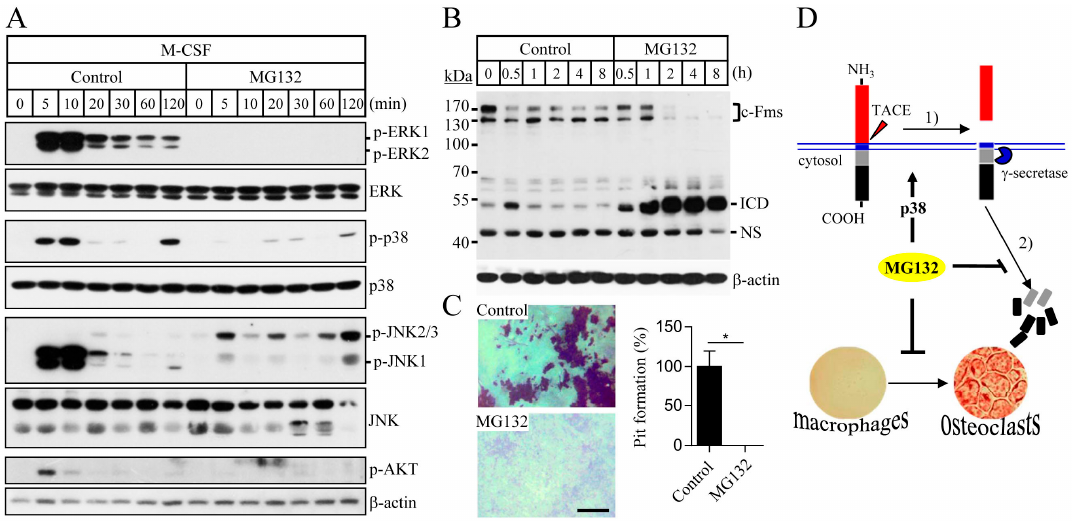
Figure 4. A proteasome inhibitor blocks M-CSF-induced intrinsic signaling and osteoclastic bone resorption. ( A ) Osteoclast progenitors were incubated with MG132 (10 μ M) for 4 h in the absence of M-CSF and then were treated with M-CSF (30 ng/mL); ( B ) osteoclast progenitors were cultured with M-CSF and RANKL for 4 days. The resulting mature osteoclasts were starved of M-CSF and RANKL, and then treated with MG132 (10 μ M). ICD, intracellular domain of c-Fms; NS, nonspecific bands; ( C ) mature osteoclasts were grown on dentin discs with M-CSF and RANKL, in the presence or absence of MG132 (10 μ M) for 24 h. The areas of resorbed pits were measured using Image-Pro Plus version 6.0. * p < 0.01. Scale bar, 100 μ m; ( D ) proposed schematic representation of the TACE-mediated c-Fms